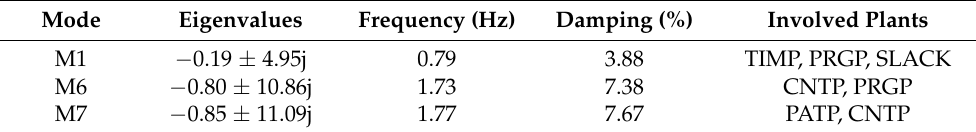
Table 12. Electromechanical modes below the threshold of 10% for the Low Load DP. Mode